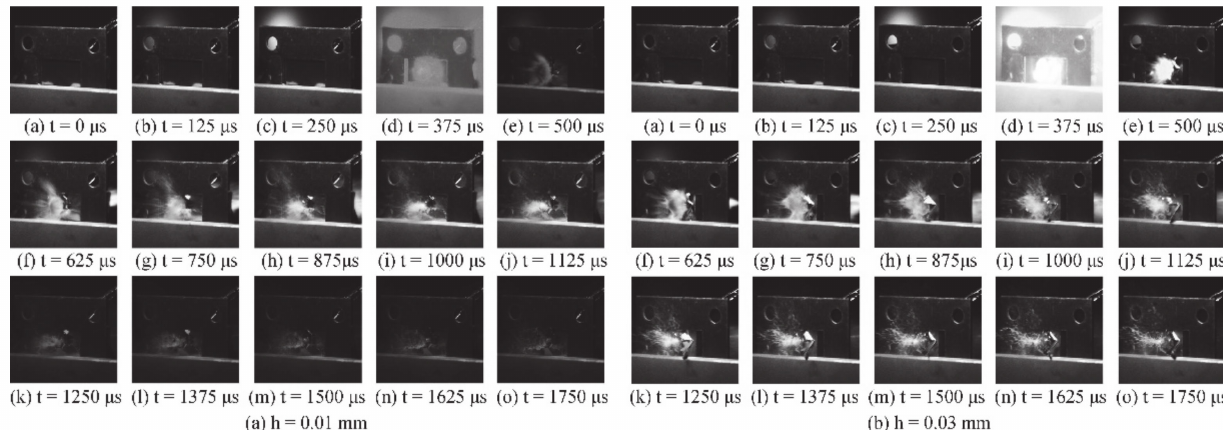
Figure 7. ( a ) Changes in the morphology of the target back at different moments when h = 0.01 mm. ( b ) Changes in the morphology of the target back at different moments when h = 0.03 mm.